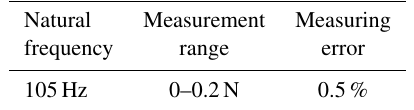
Table 3. System parameters of self-developed force balance. Natural